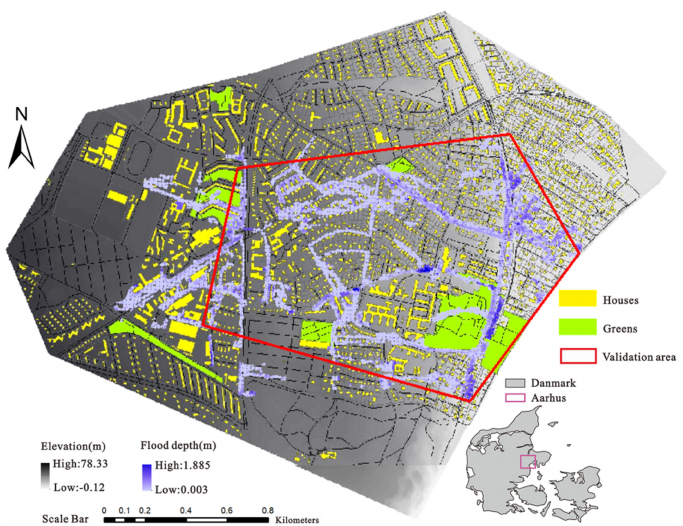
Figure 10. Descriptions of the land use, topography and flood map used as the validation scenario.